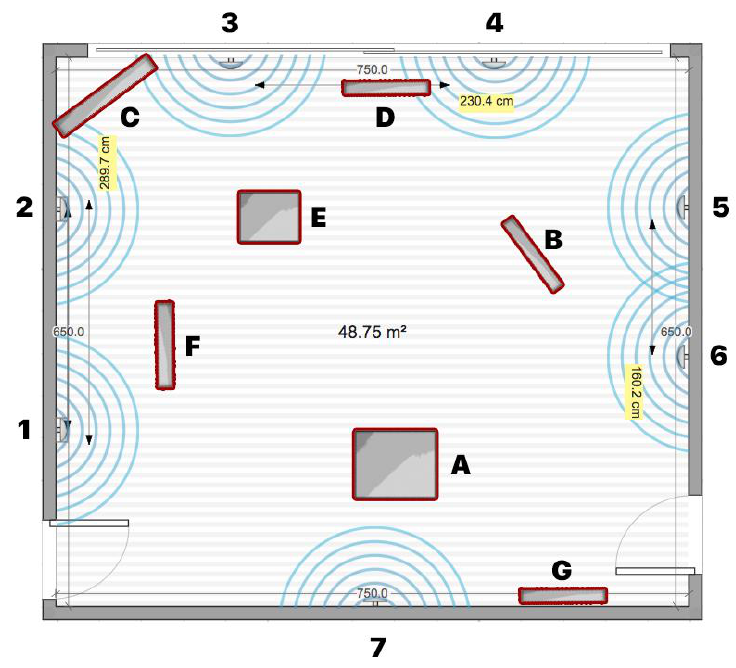
Figure 8. Testing environment with a higher level of obstacle severity.